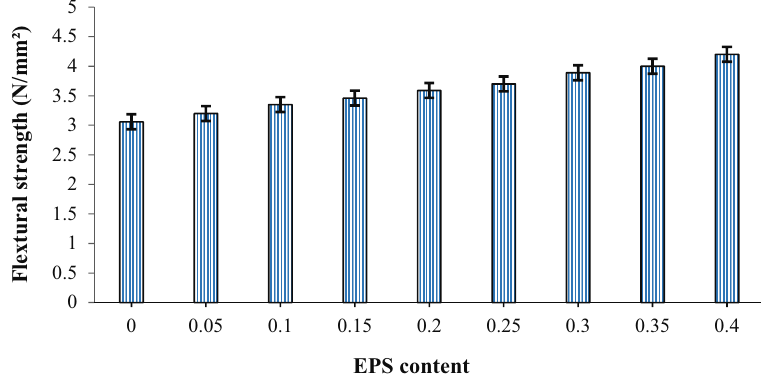
Figure 2: EPS - AC fl exural strength versus EPS content.